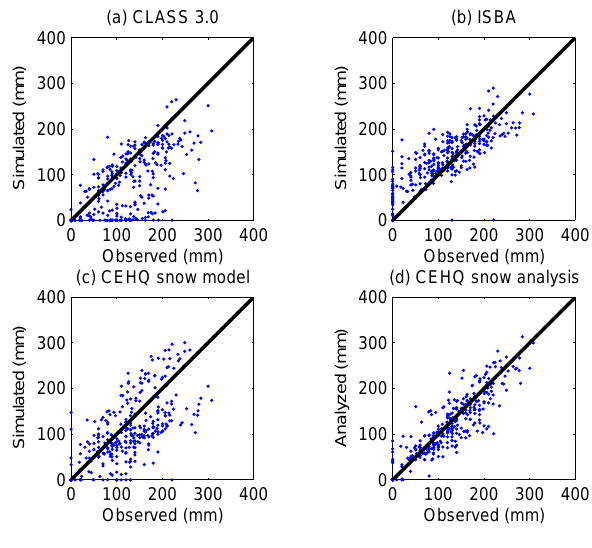
Fig. 15. Verification of MESH SWE predictions against snow sur- vey observations used in the CEHQ